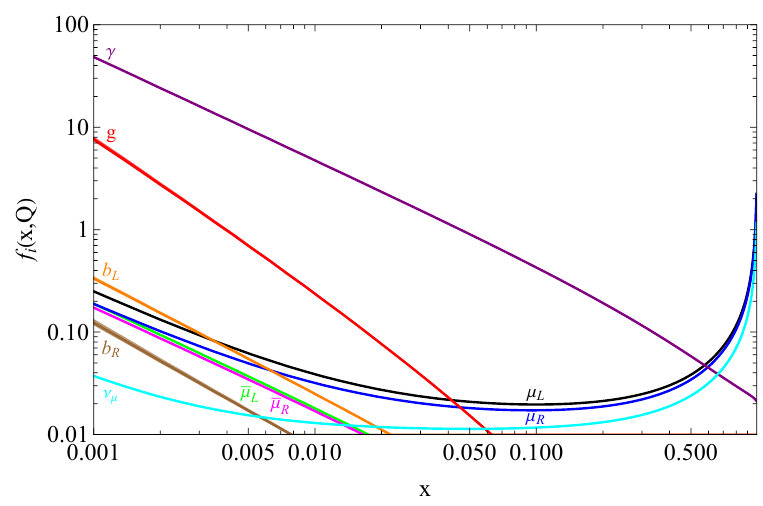
Figure 18 . Muon PDFs including the full unbroken SM interactions for Q = 3 TeV. The thickness of the gluon and b quarks PDFs is obtained by varying the µ QCD scale from 0.5 to 1 GeV. evolution, below the electroweak scale Q = µ